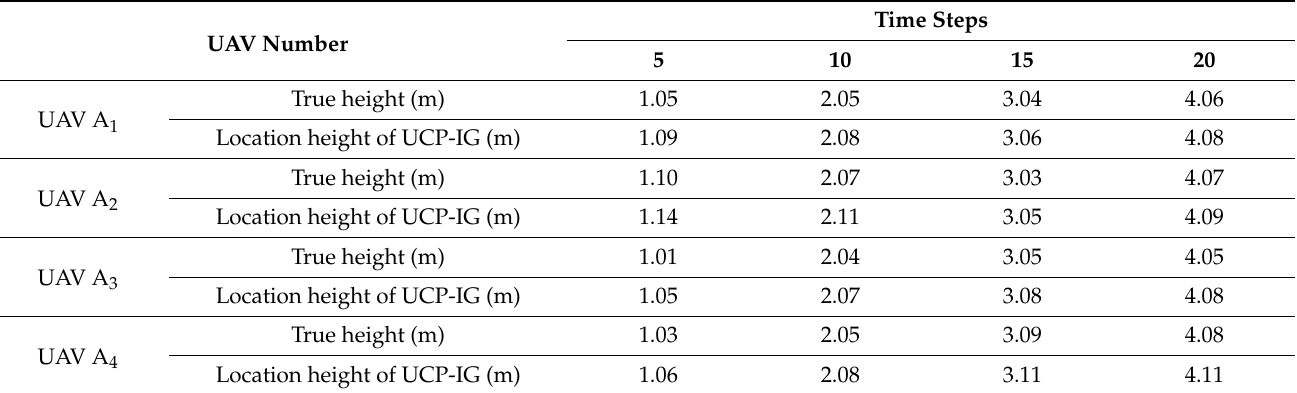
Table 2. Part of the experimental data (comprehensive scenario).